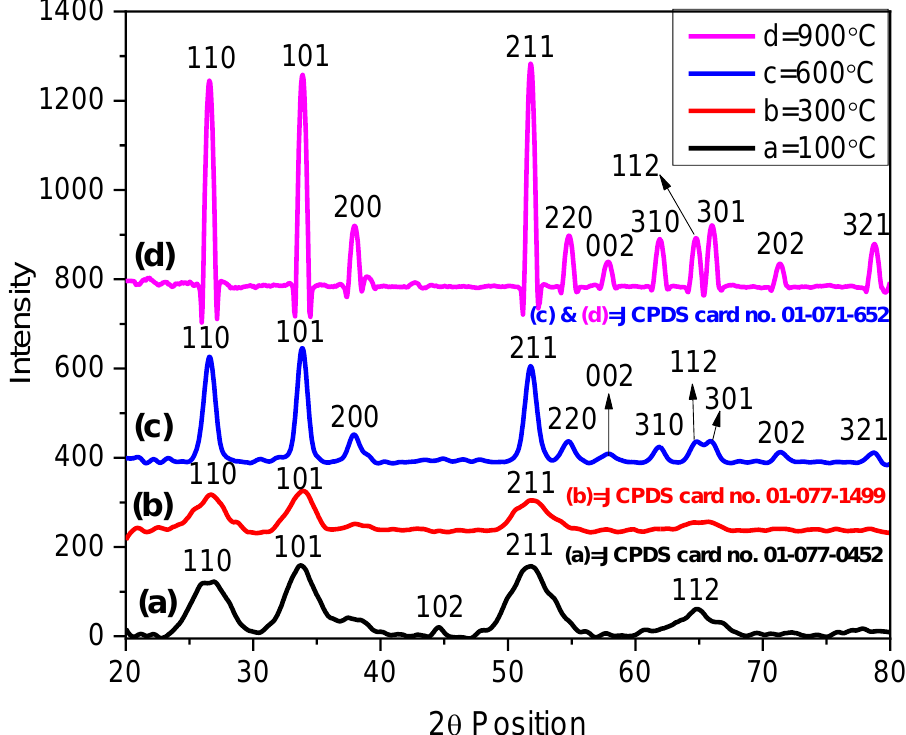
Figure 1. X-ray diffractogram of SnO 2 NPs calcined at different temperatures. The diffractogram for SnO 2 NPs calcined at 100 ◦ C has definite peaks at 2 θ 26.75(110), 34.07(101), and 51.62(211), which fits to the reference card No. 00-001-0625. It confirms the cassiterite crystal phase of SnO 2 NPs having tetragonal geometry. The peaks at 44.54(210) and 64.80(112), which correspond to JCPDS card No. 01-077-0452 are due to an unknown SnO 2 crystal